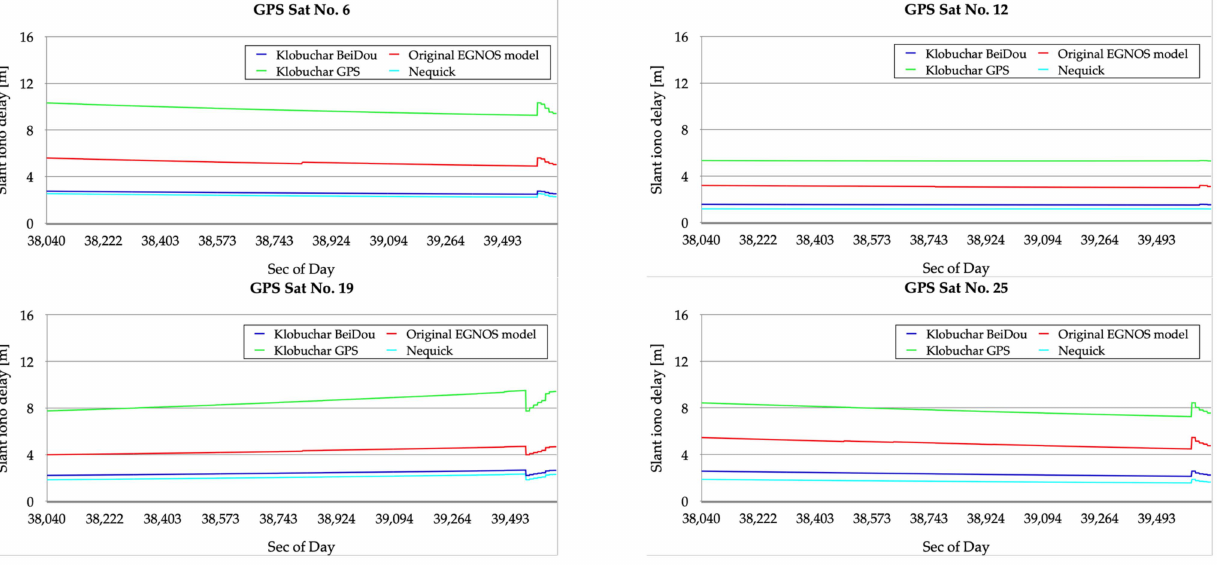
Figure 4. Ionospheric delay values for selected satellites associated with GPS/EGNOS positioning in different variants of the ionospheric model used: Klobuchar BeiDoU, Klobuchar GPS, NeQuick, and original EGNOS